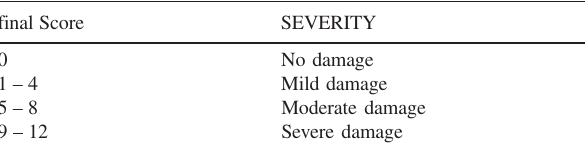
Table 2 - Final pathoanatomical index